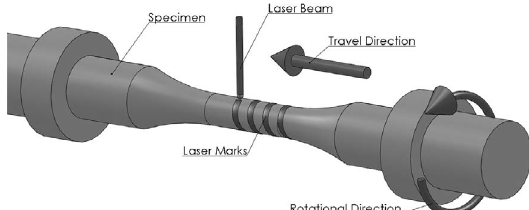
Figure 2. Illustration of the specimen rotation and laser beam path.